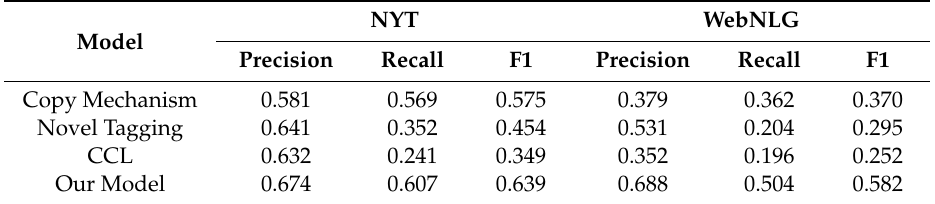
Table 1. Comparison of results of our model and baselines in New York Time (NYT) and WebNLG